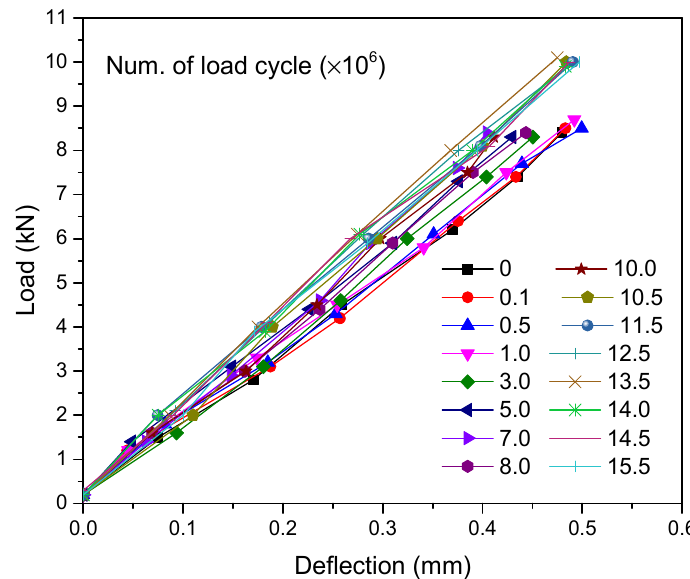
Figure 19. Load-span deflection curve.